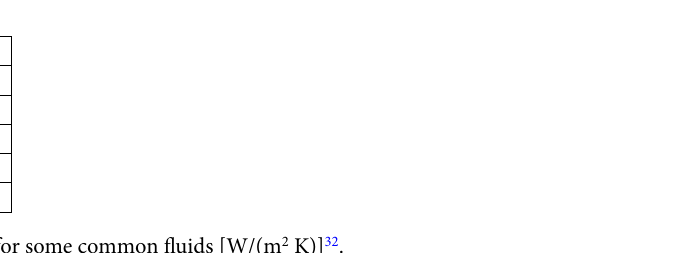
Table 2. Heat transfer coefficient for some common fluids [W/(m 2 K)] 32